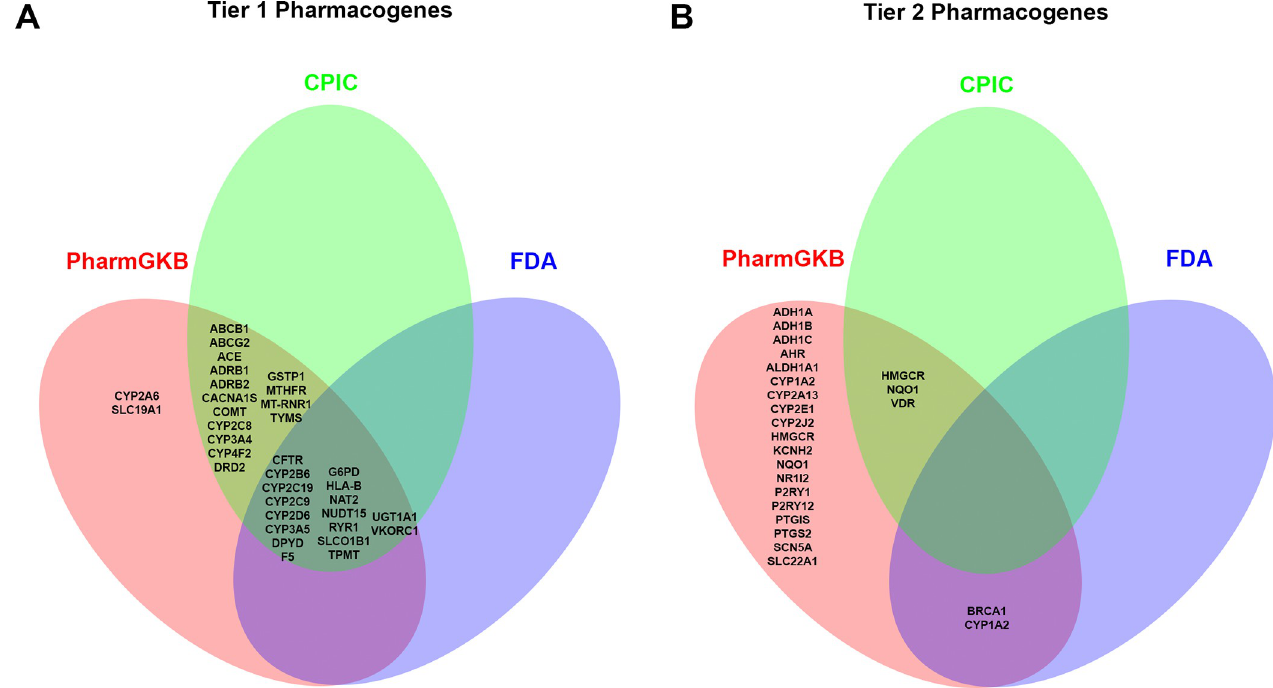
Fig 1. Comparison of tiered pharmacogene sources. Venn diagrams of Tier 1 (A) and Tier 2 (B) pharmacogenes included from the three sources: PharmGKB (red), CPIC (green), and the FDA (blue).